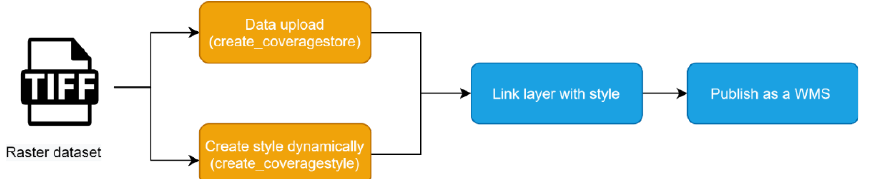
Figure 2. workflow for publishing the WMS standard for raster dataset